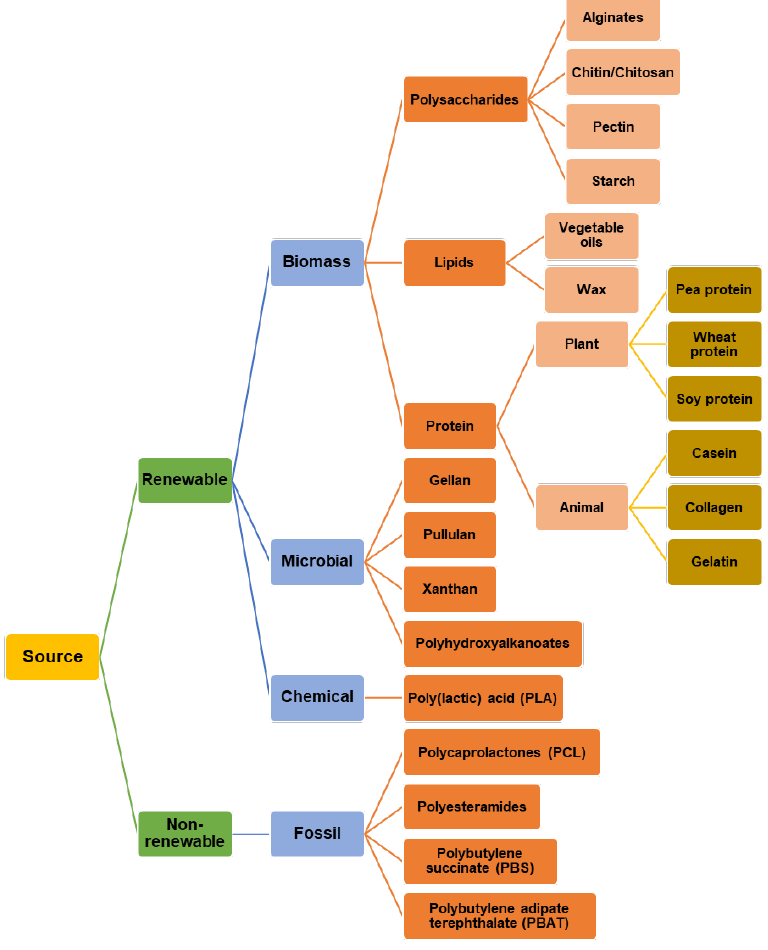
Figure 1. Classification of biodegradable materials used in biobased packaging.